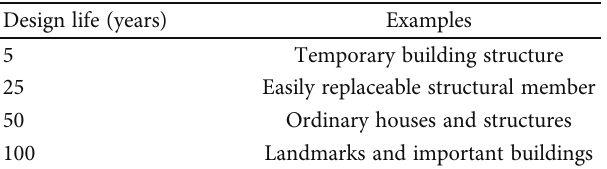
Table 6: Design life of building structures.